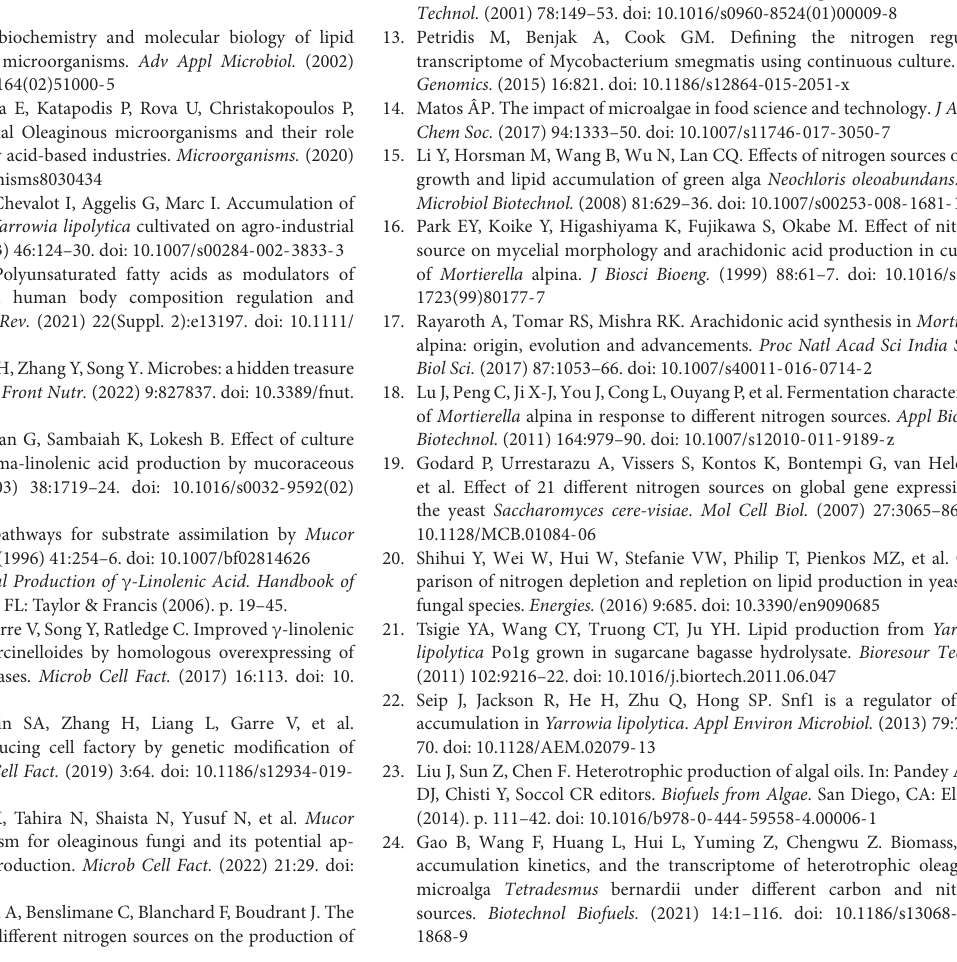
Supplementary Figure 1 | Microscopic Images of lactophenol cotton blue-stained mycelia of Rhizomucor pusillus AUMC 11616.A (A) branched sporangiophores and (B) primitive rhizoides ; and M. circinelloides AUMC 6696.A (C) sporangiophores and (D) sporangiophores carrying sporangium and spores. Supplementary Figure 2 | The GC results of the detailed FAs chromatographic